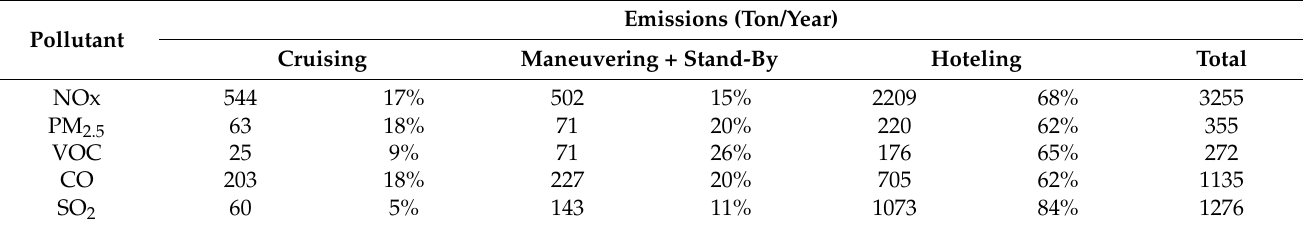
Table A25. Total emissions from vessels (Ashdod, MPS A2